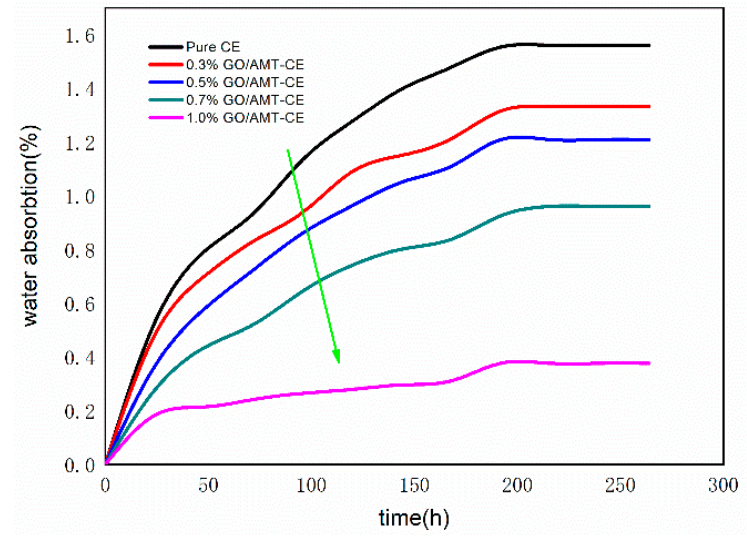
Figure 8. Water absorption of GO/AMT-CE composites with different GO/AMT contents.